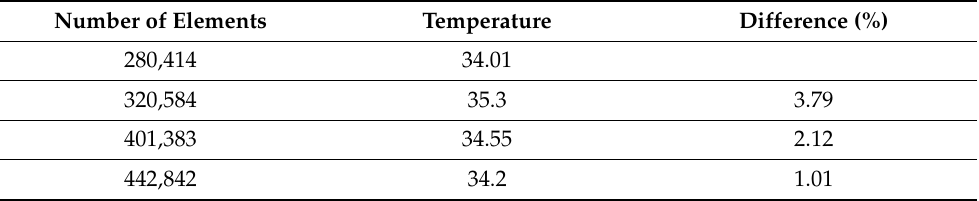
Table 4. Mesh convergence study for patient number